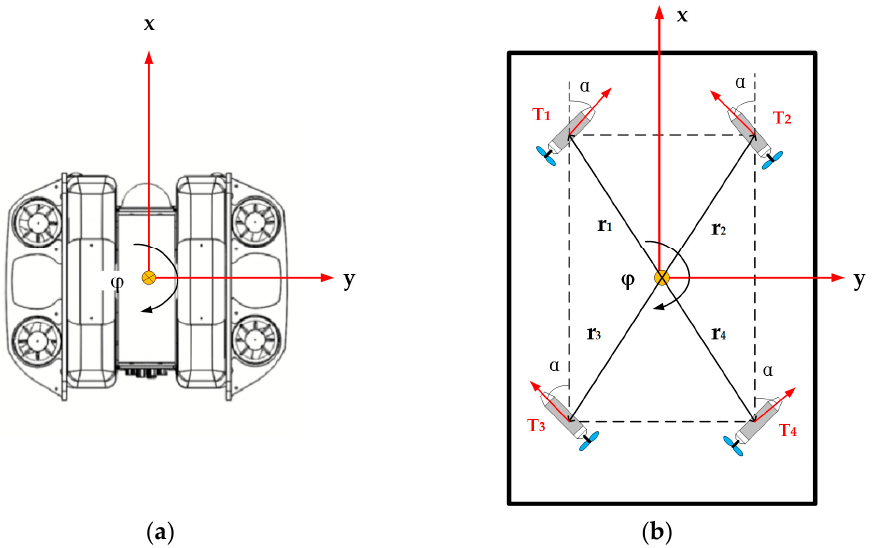
6 of 25 Table 2. Correspondence table of meanings of kinetic model parameters. Parameter